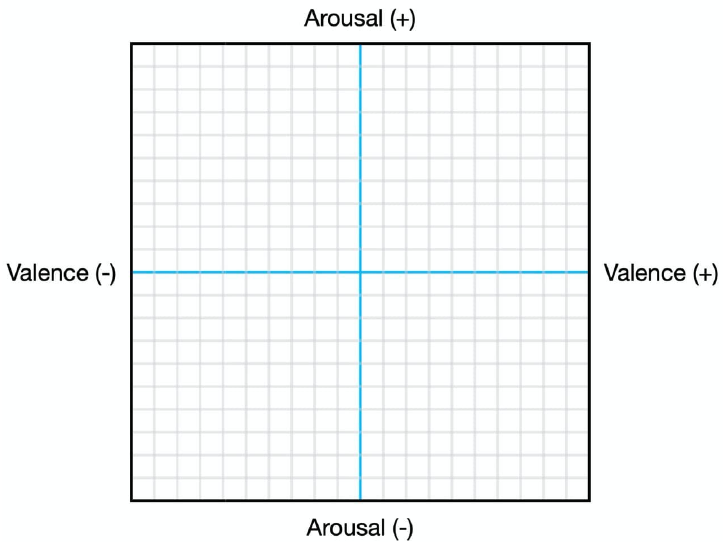
Figure 2. The interface through which valence and arousal values were captured via mouse tracking in the listening